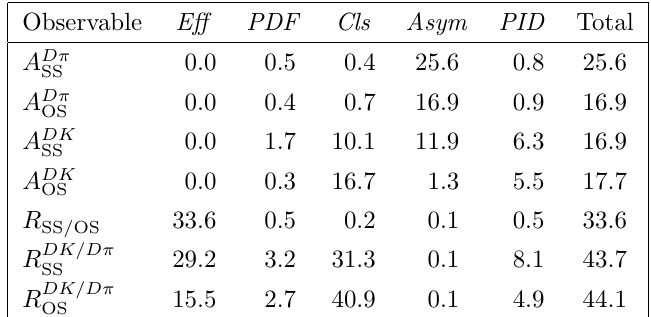
Figure 3 . Invariant mass of OS B (cid:6) components are detailed in the legend of (cid:12)gure 2.